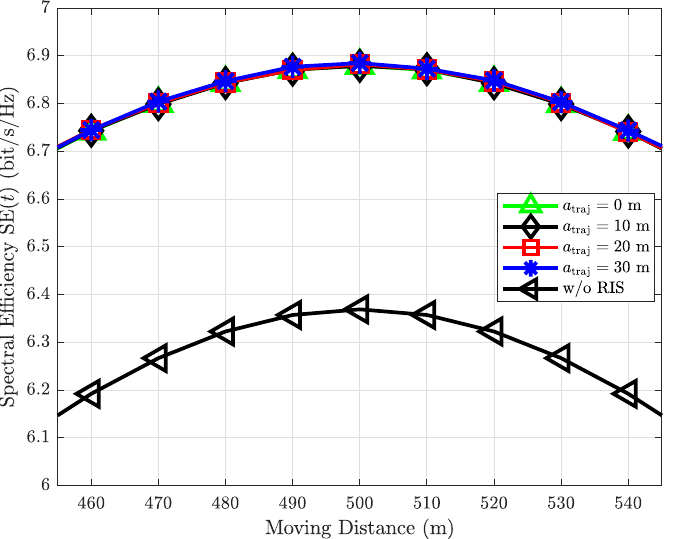
Figure 11. Spectral efficiency for one vehicle pass with random errors in trajectory. K =